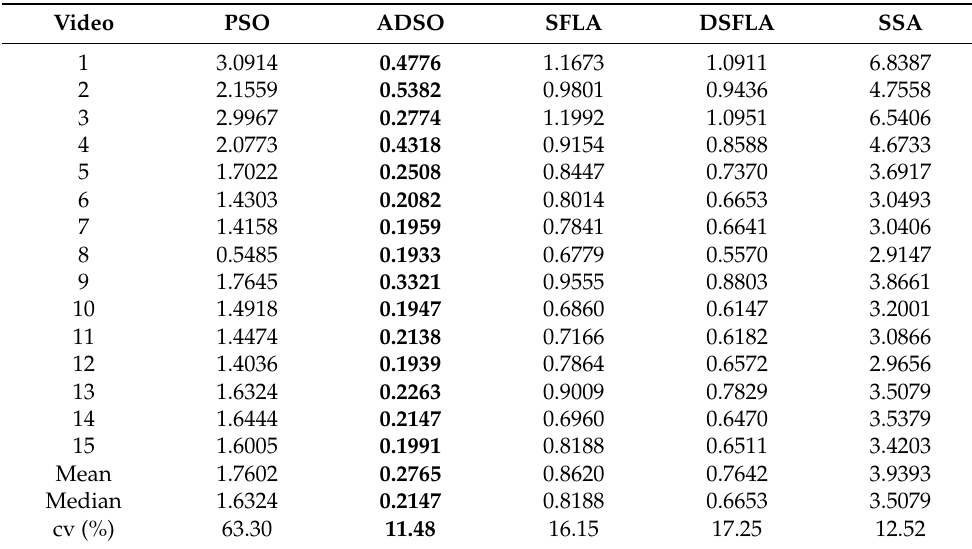
Table 3. Processing time per frame (s) (the best results are in bold).